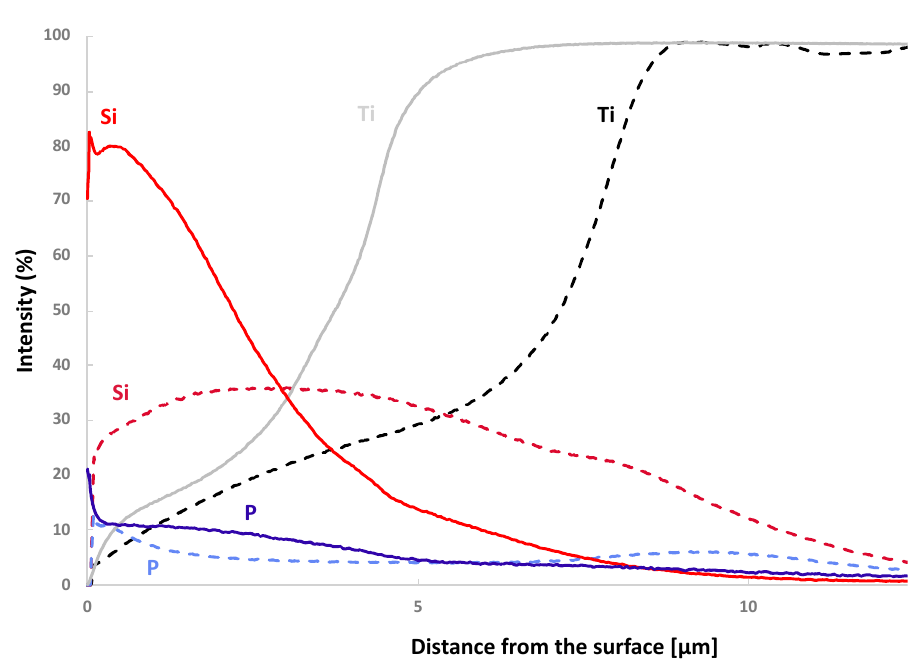
Figure 5. GD-OES depth profiles of Si, Ti and P measured from the free surface of PEO double layers DA (abrasive-blasted, solid lines) and DB (as-treated, dashed lines) obtained by treatment in silicate bath followed by phosphate bath.